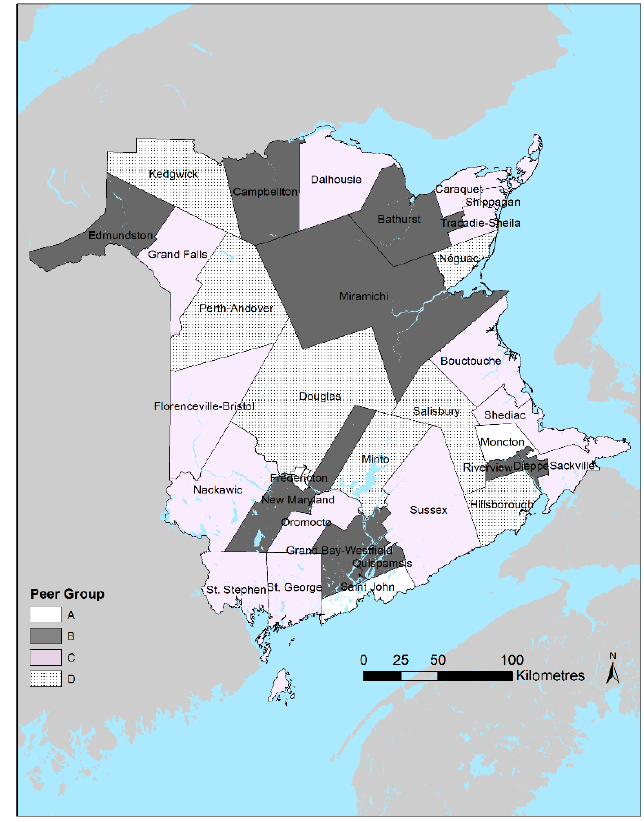
Figure 1. Peer groups for New Brunswick Health Council Communities. Peer Groups A through D represent a continuum where A = Relatively urban, D = relatively rural.